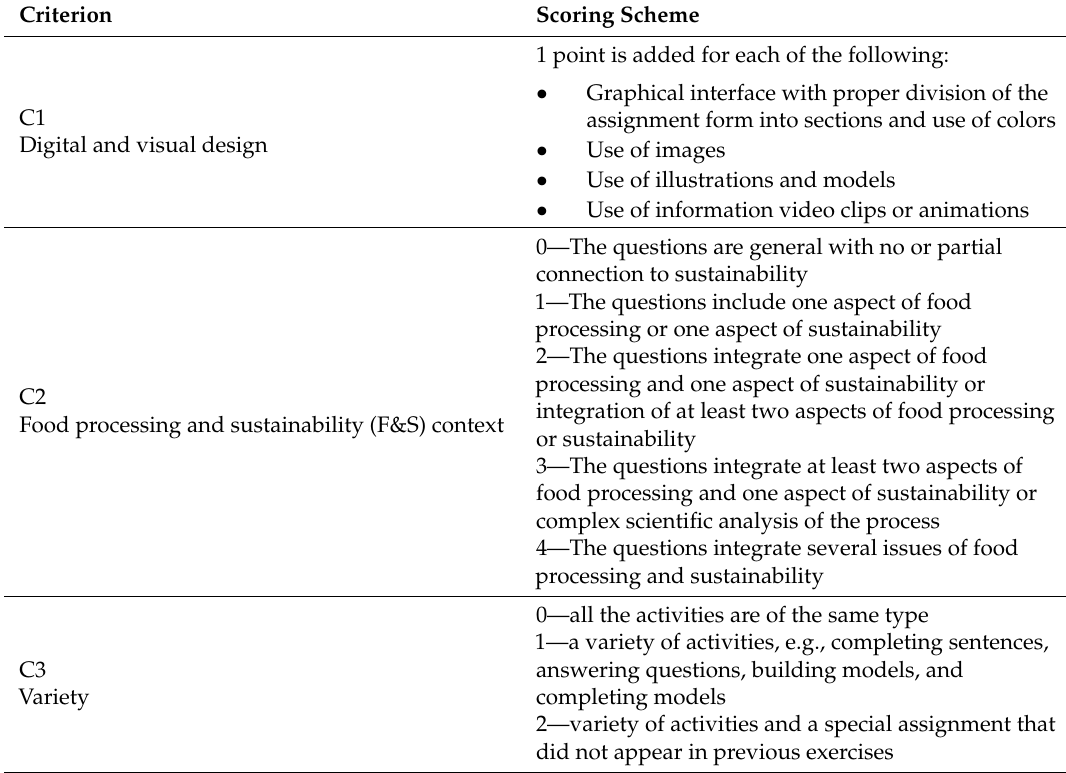
Table 5. The Scientific Understanding Rubric